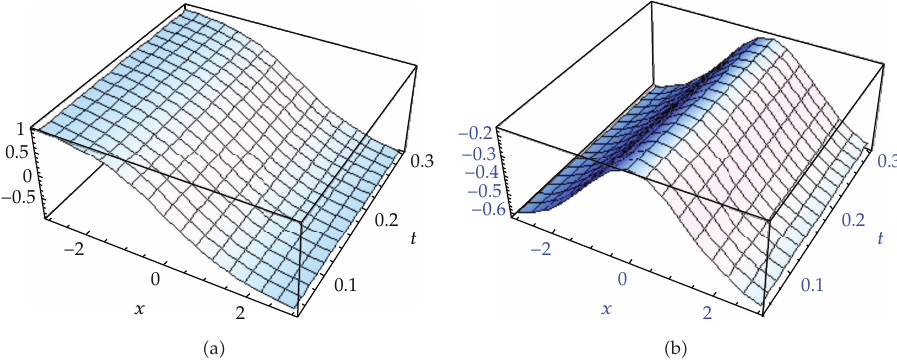
Figure 4: (cid:2) a (cid:3) The obtained u HAM for system (cid:2) 1.2 (cid:3) using 10-term approximation. (cid:2) b (cid:3) The obtained v HAM for system (cid:2) 1.2 (cid:3) using 10-term approximation. h (cid:8) − 1 .